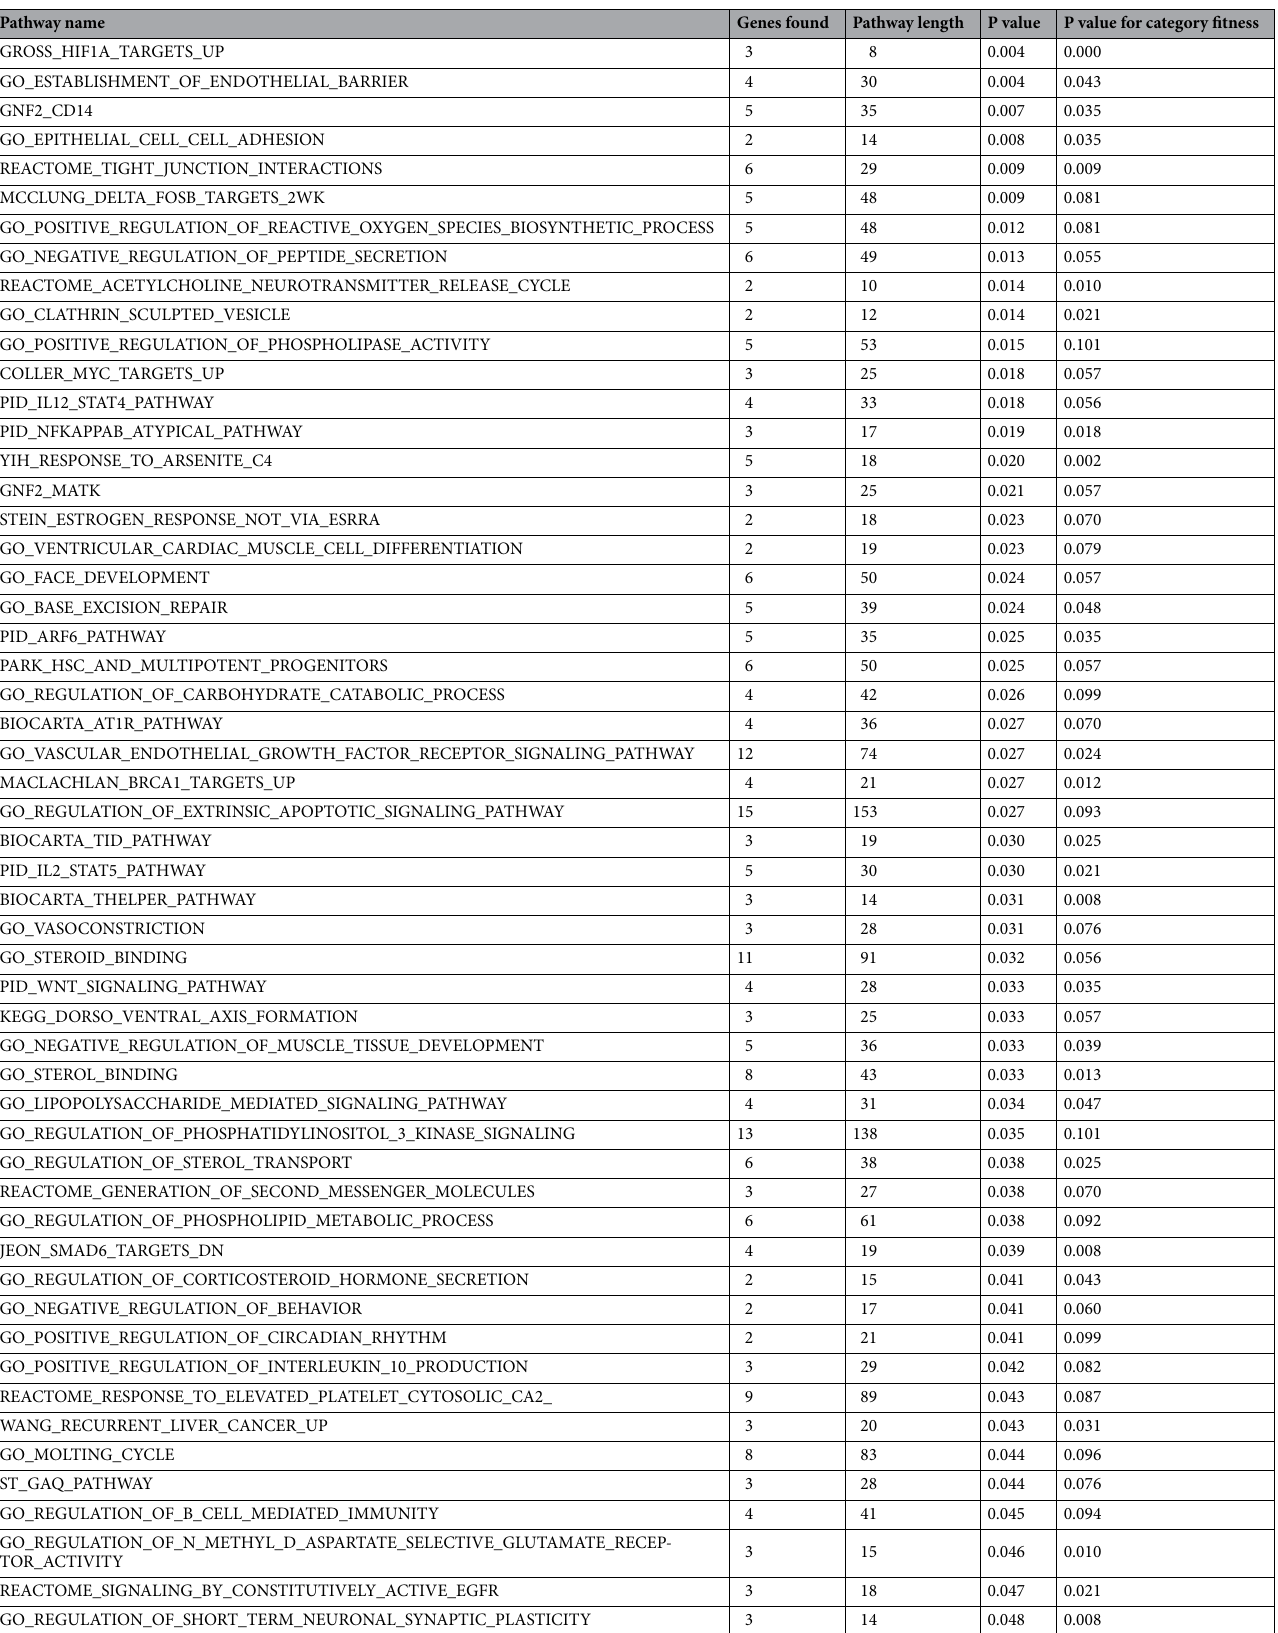
Table 1. Significantly regulated pathways in dimensionality reduction-based pathway analysis of the shRNA library screen. Pathways with adjusted rounded P values ≤ 0.05 and rounded P values for category fitness ≤ 0.1 are